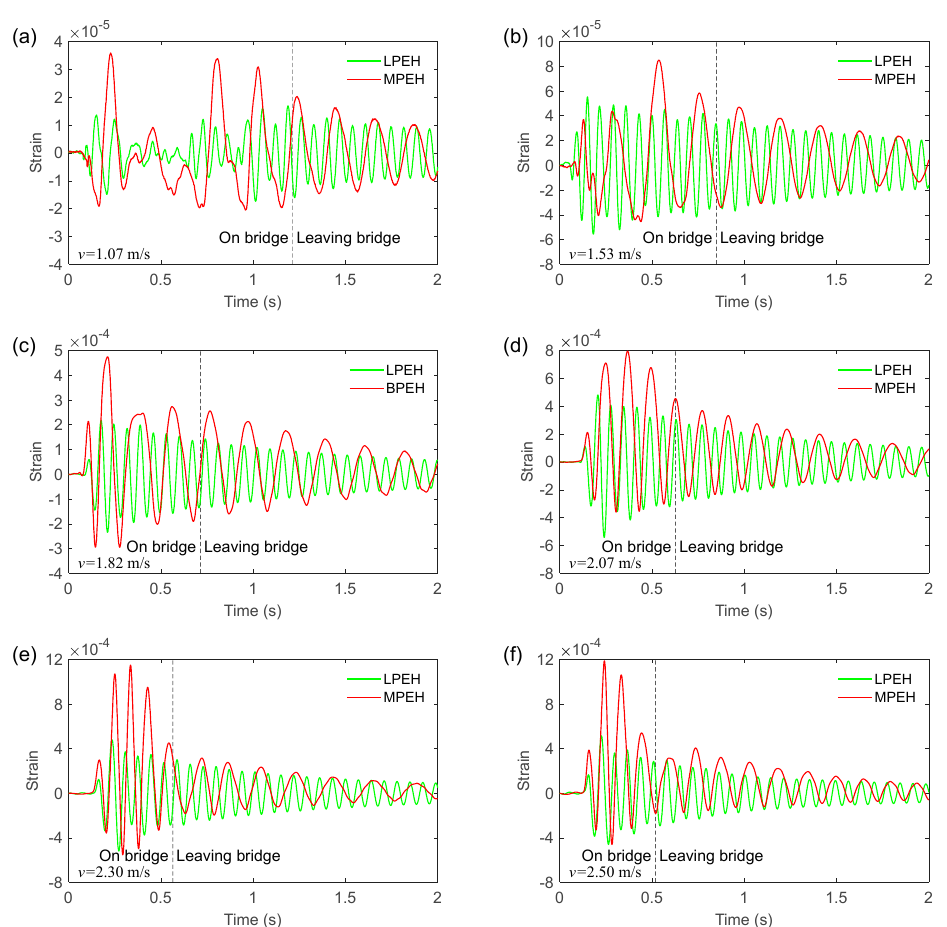
Figure 9. Strain responses of the LPEH and the MPEH for the vehicle travelling on and leaving the bridge: ( a ) v = 1.07 m/s, ( b ) v = 1.53 m/s, ( c ) v = 1.82 m/s, ( d ) v = 2.07 m/s, ( e ) v = 2.30 m/s and ( f ) v = 2.50 m/s.